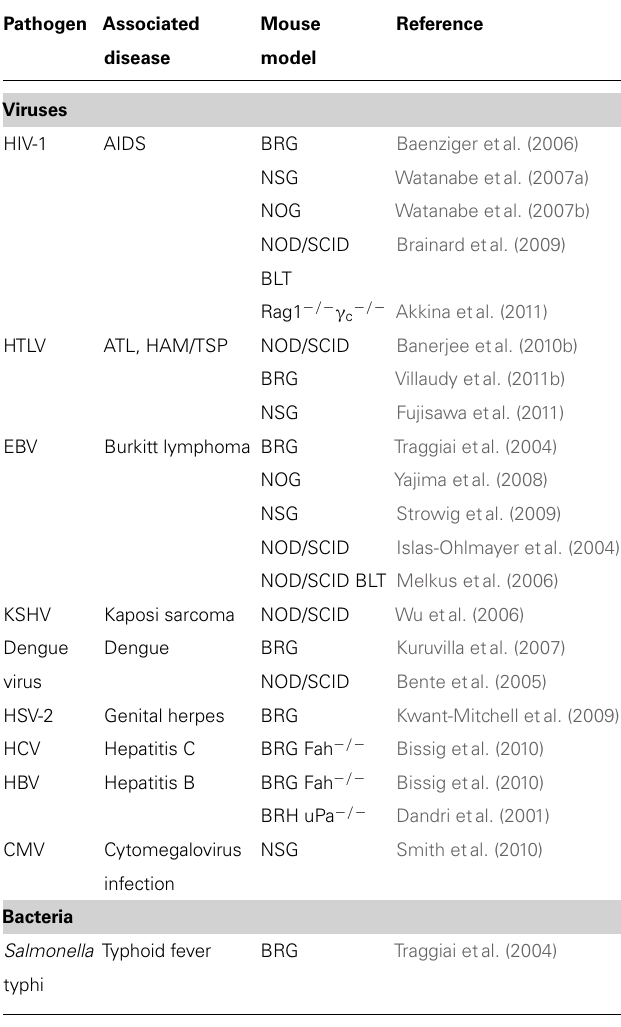
The humanized HIS mice are now used as in vivo models in both basic and preclinical research fields. Clearly, human- ized mice represent a potent translational model for studying human hematopoiesis, immunity, gene therapy, infectious dis- eases, cancer, and regenerative medicine without putting patients at risk. ESTABLISHING HIS MICE AS A MODEL TO STUDY HTLV-1 INFECTION AND PATHOGENESIS Human T cell development in HIS mice Human immune system mice are generated according to the procedure previously described (Traggiai et al., 2004) and sum- marized in Figure 3